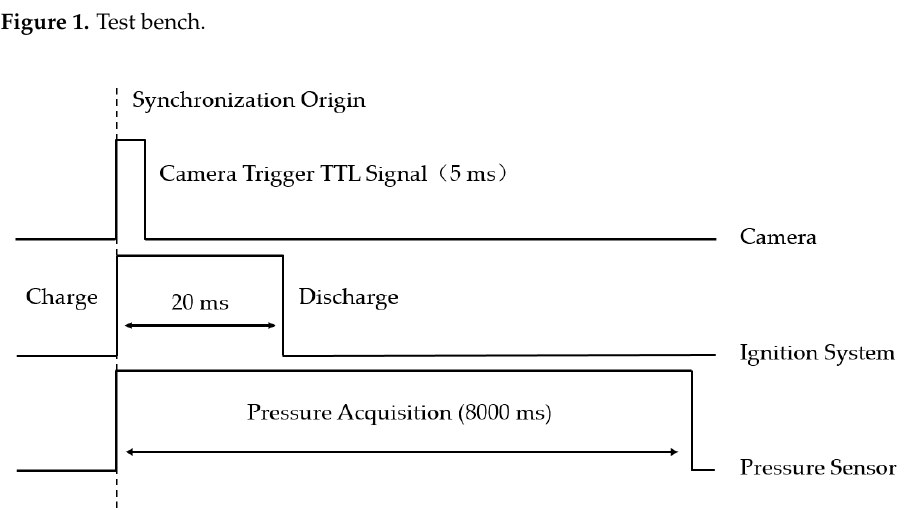
Figure 1. Test bench.